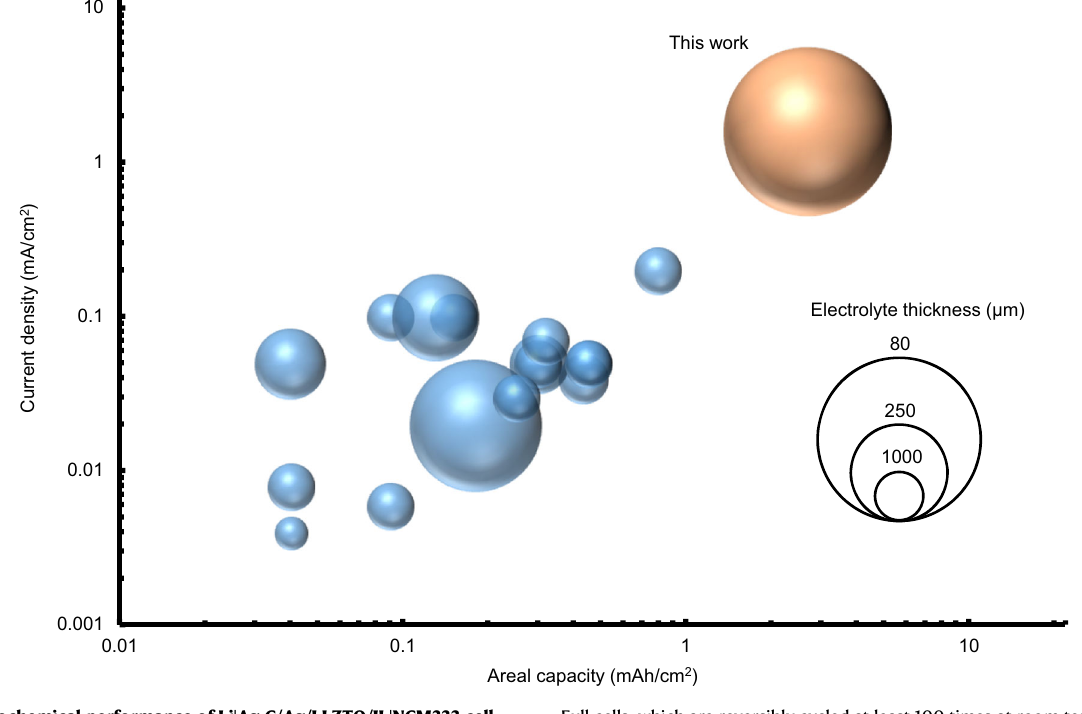
Full cells, which are reversibly cycled at least 100 times at room temperature, are presented. Additional details such as cell con fi guration and number of reversible cycles are summarized in Supplementary Table